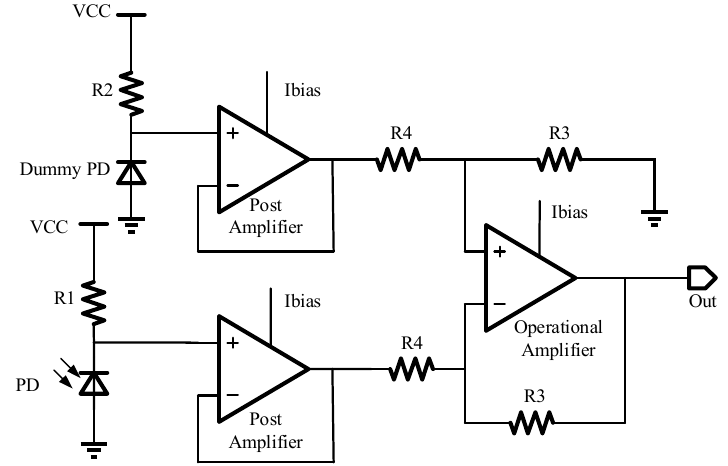
Figure 8. Schematic diagram of the receiving circuit.